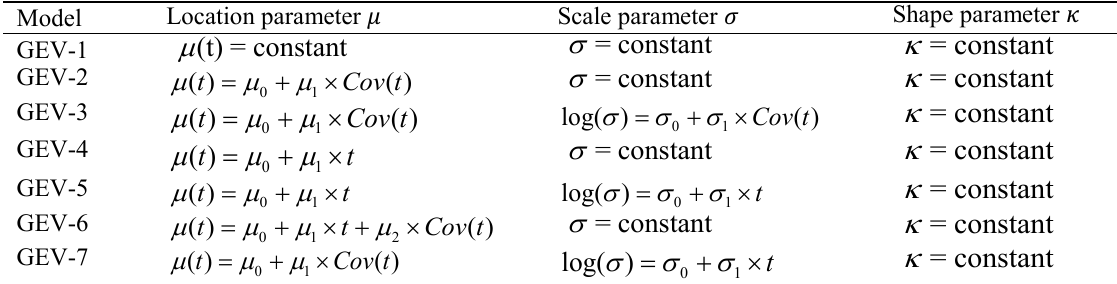
Table 1 Different GEV models parameter. Cov is used for the covariate which may be sea surface temperature (SST) or sea level pressure (SLP) of the Gulf of Guinea.